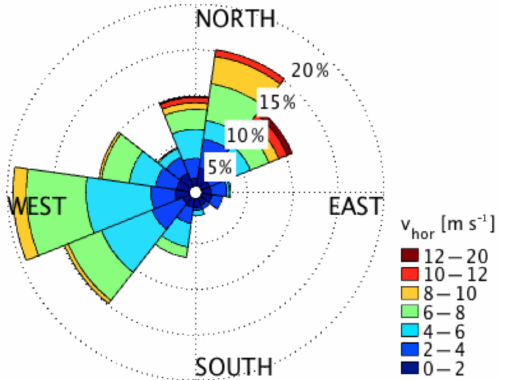
Figure 5. Sector-wise frequency and velocity distribution derived from diamond scan